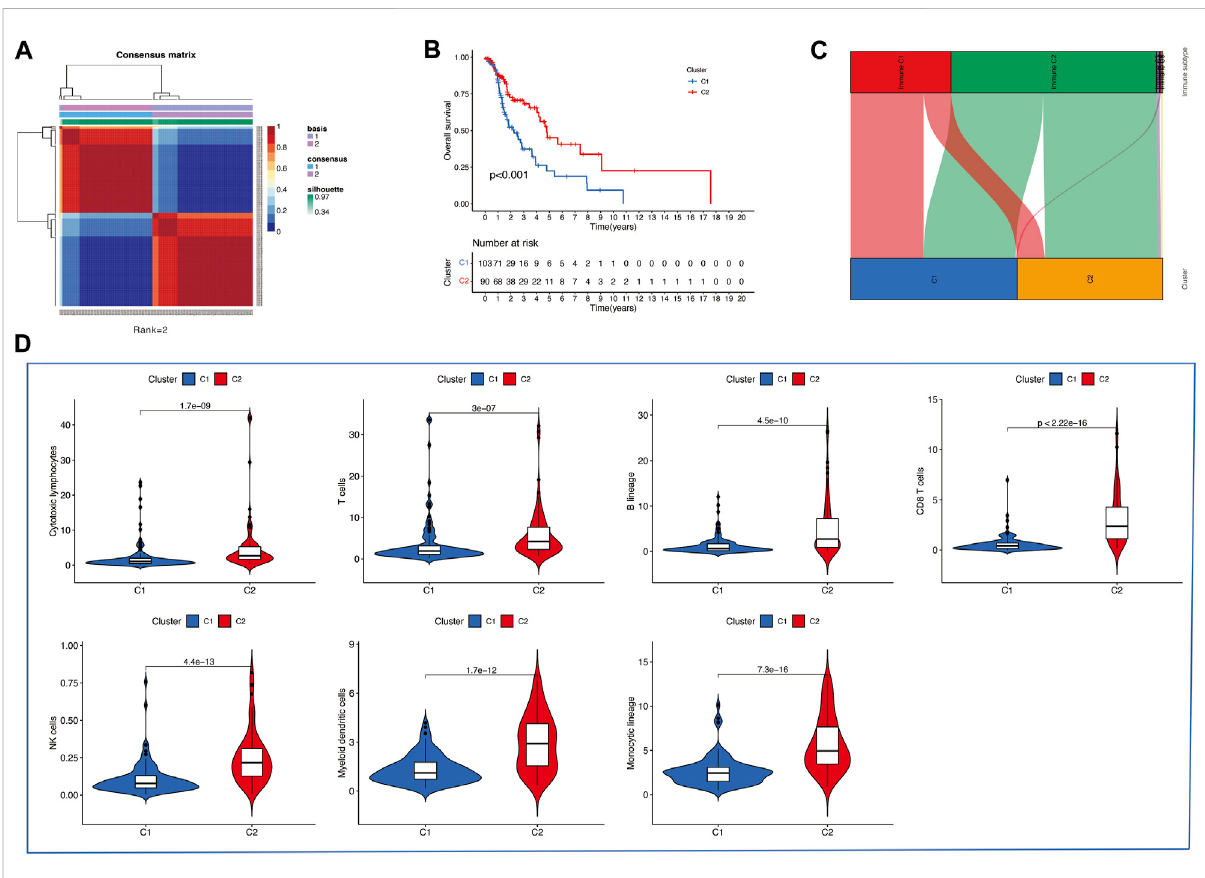
FIGURE 3 (A) Consensus map of the NMF clustering data of TCGA HNSCC cohort. Rank = 2 means that HNSCC patients were separated into two groups. (B) Survival curve of OS (P= < 0.001) in cluster 1 and 2. (C) Sankey plot to show the association between different subtypes and immune subtypes. (D) Differential analysis of tumor-in fi ltrating immune cells was conducted using